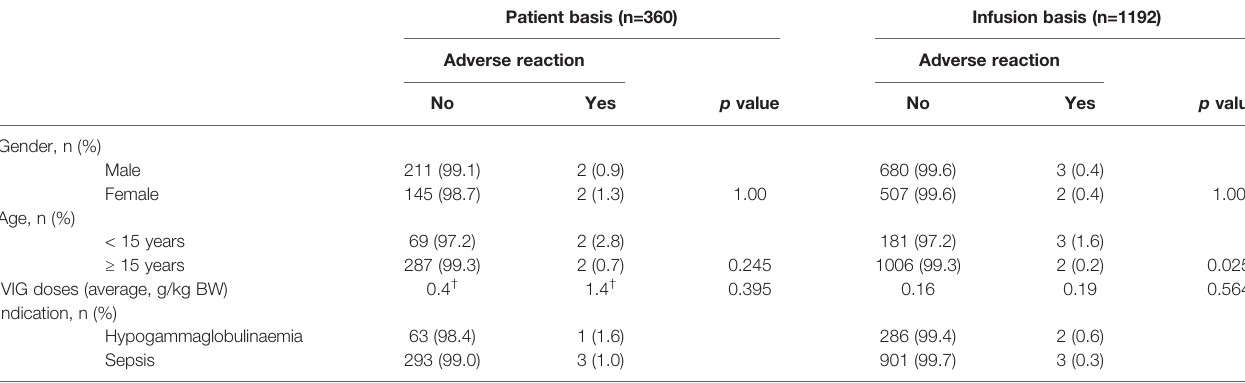
TABLE 3 | Factor-speci fi c incidences of adverse reactions to low-dose